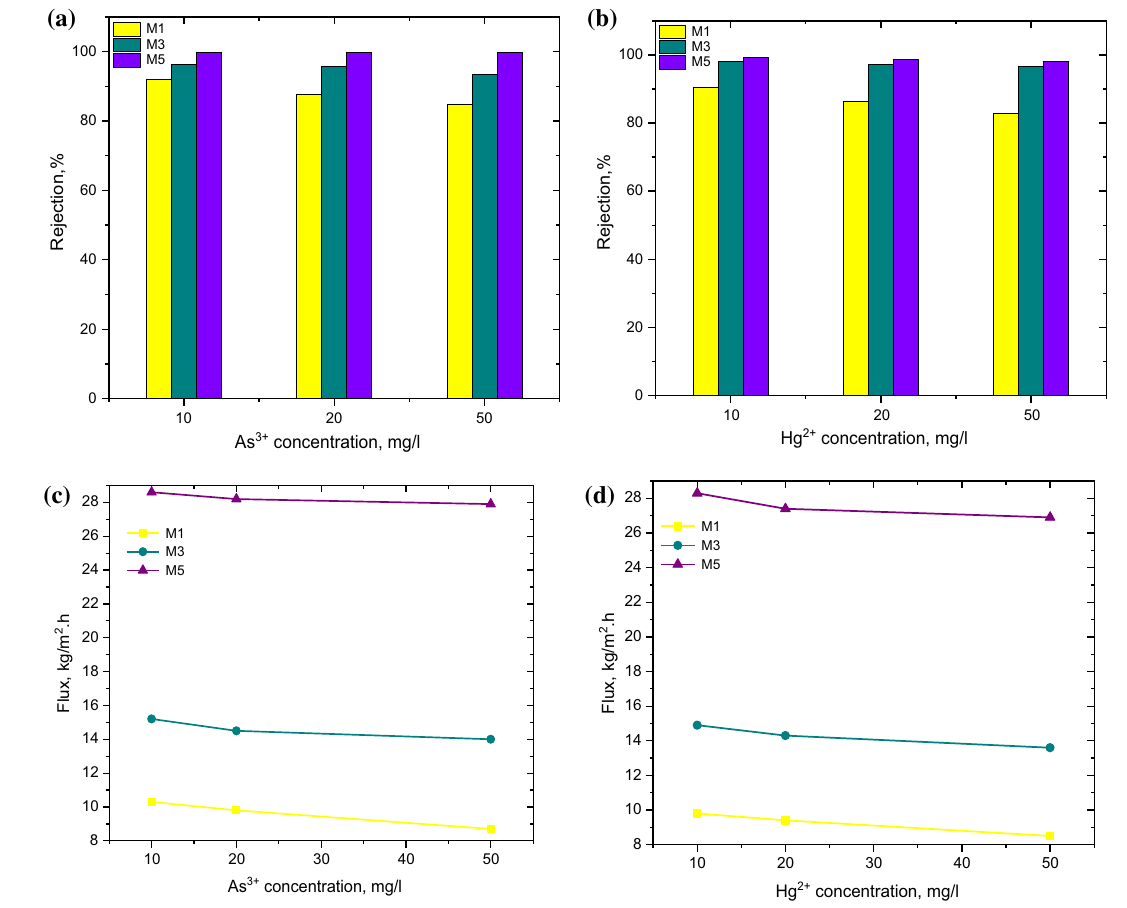
Fig. 10 The rejection data of As 3+ ( a ), Hg 2+ ( b ) and permeation flux data of As 3+ ( c ) and Hg 2+ ( d ) for M1, M3 and M5 membranes at different feed concentrations of 10, 20 and 50 mg/l